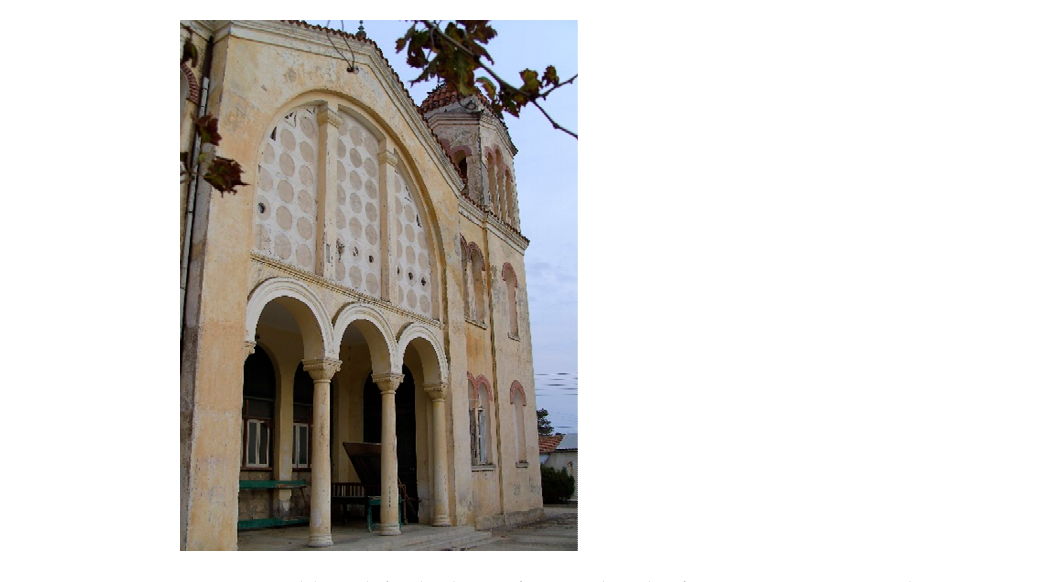
Figure 5. Yedikonuk/Ephtakomi, former church of St. George, converted to a mosque after 1974 (now unused), west façade (photo: authors).